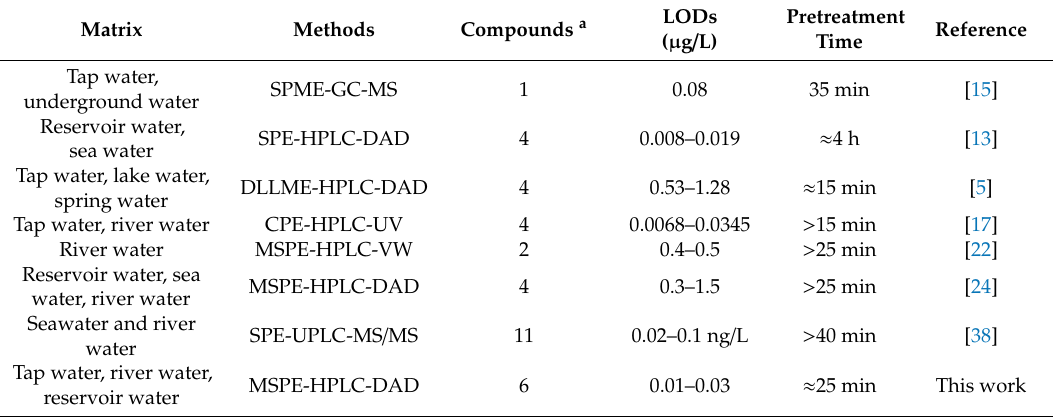
Table 4. Method comparisons for analysis of heterocyclic pesticides in water samples.